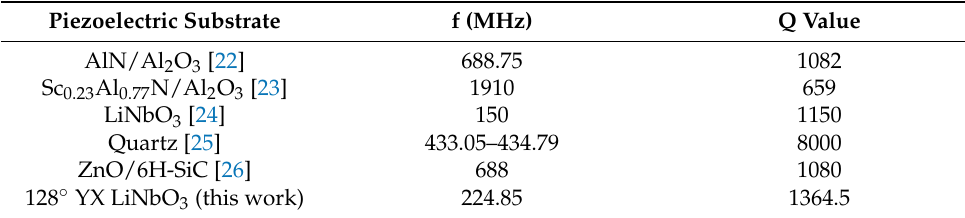
Table 2. Comparison works on performance of SAW